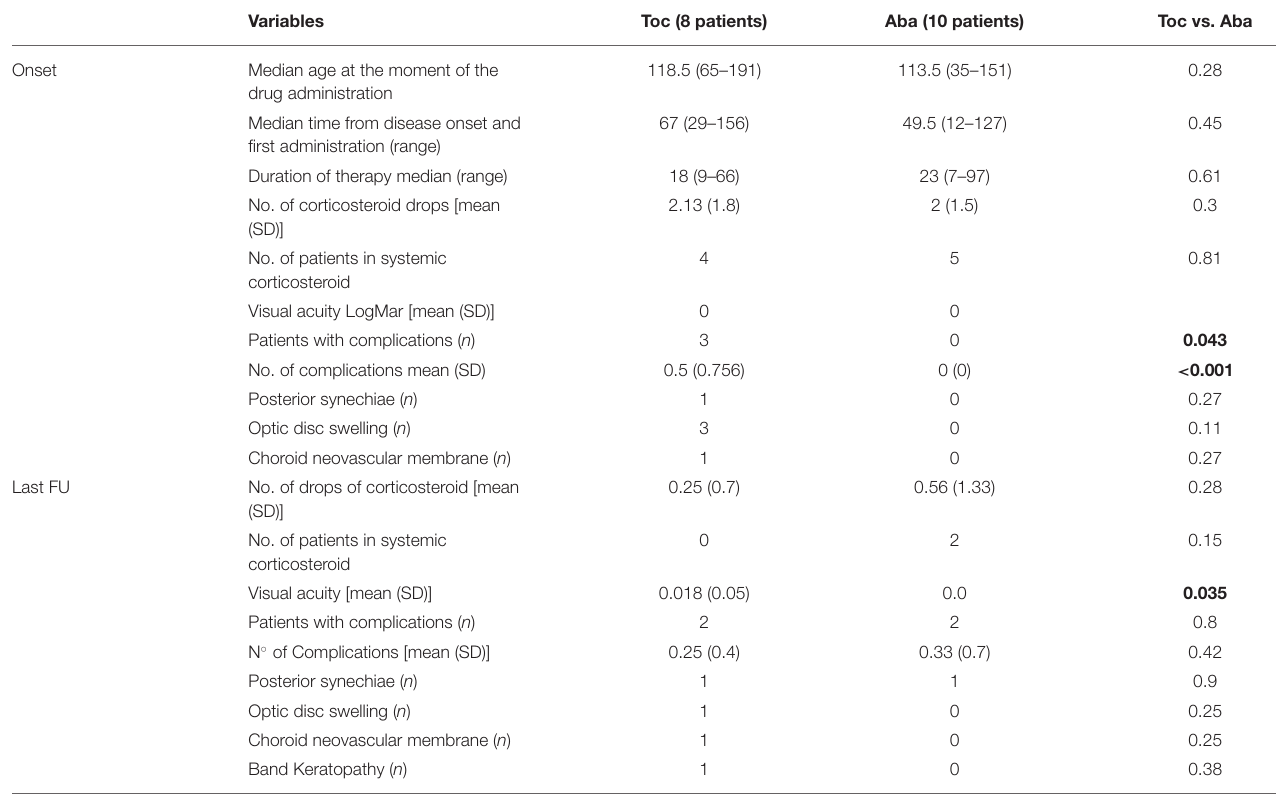
TABLE 2 | The characteristics of eyes in the two groups of treatment at the baseline and at the last available follow-up on treatment.